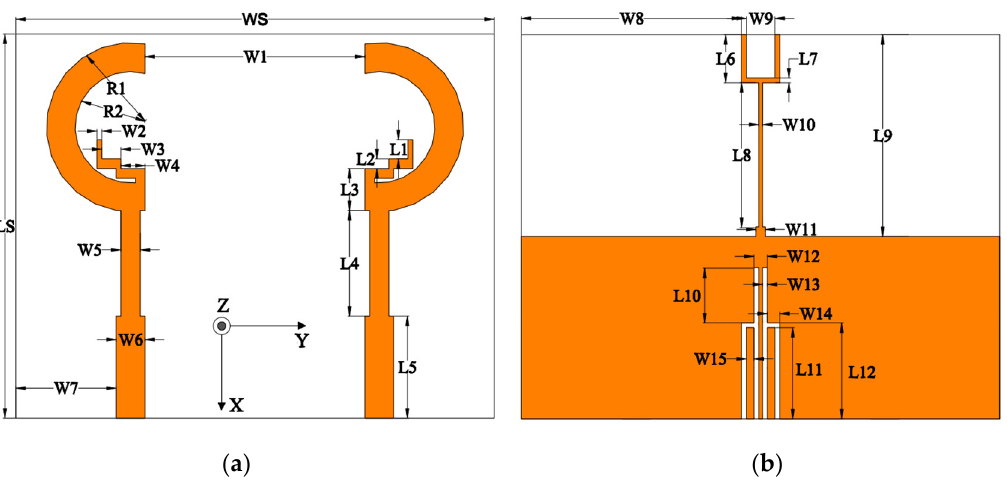
Figure 1. Geometry of the proposed antenna. ( a ) Top view; ( b ) bottom view.